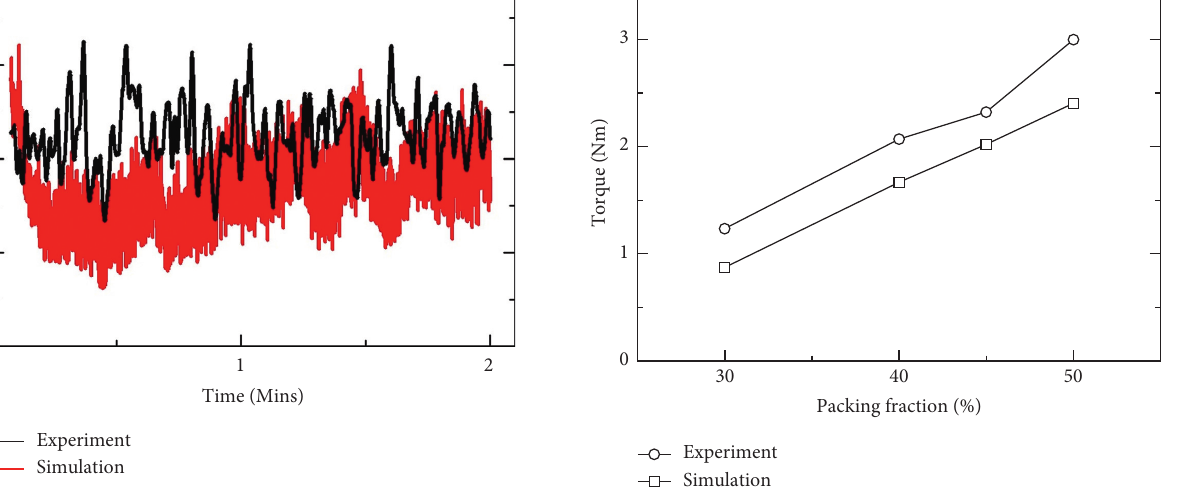
Figure 7: Experimental and simulation results of the torque versus packing fraction curve using elastomer particles of 3 mm diameter in the no-gap model. The rotational speed is